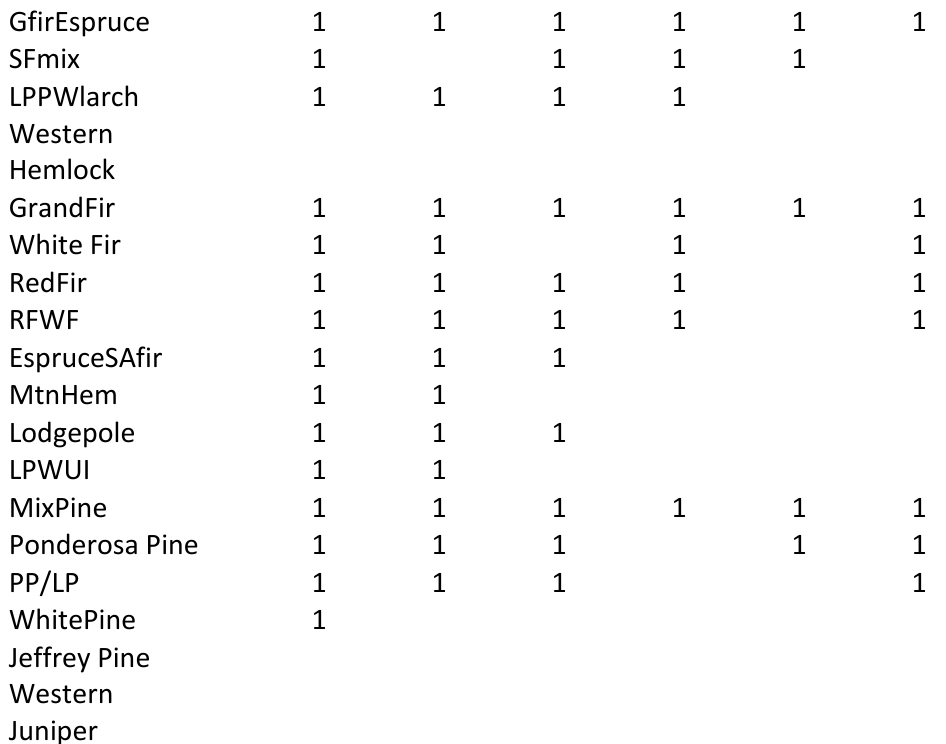
Table A8.6 Scores for species by PVT Region PVT AM BBWO NOGO PIWO WEBL WHWO Idaho fescue Bluebunch wheatgrass -